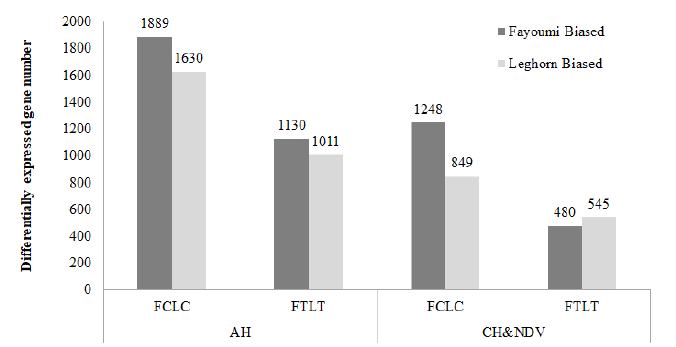
Figure 1. The comparison groups with acute heat stress and chronic heat stress & NDV infection for RNA-seq analysis.